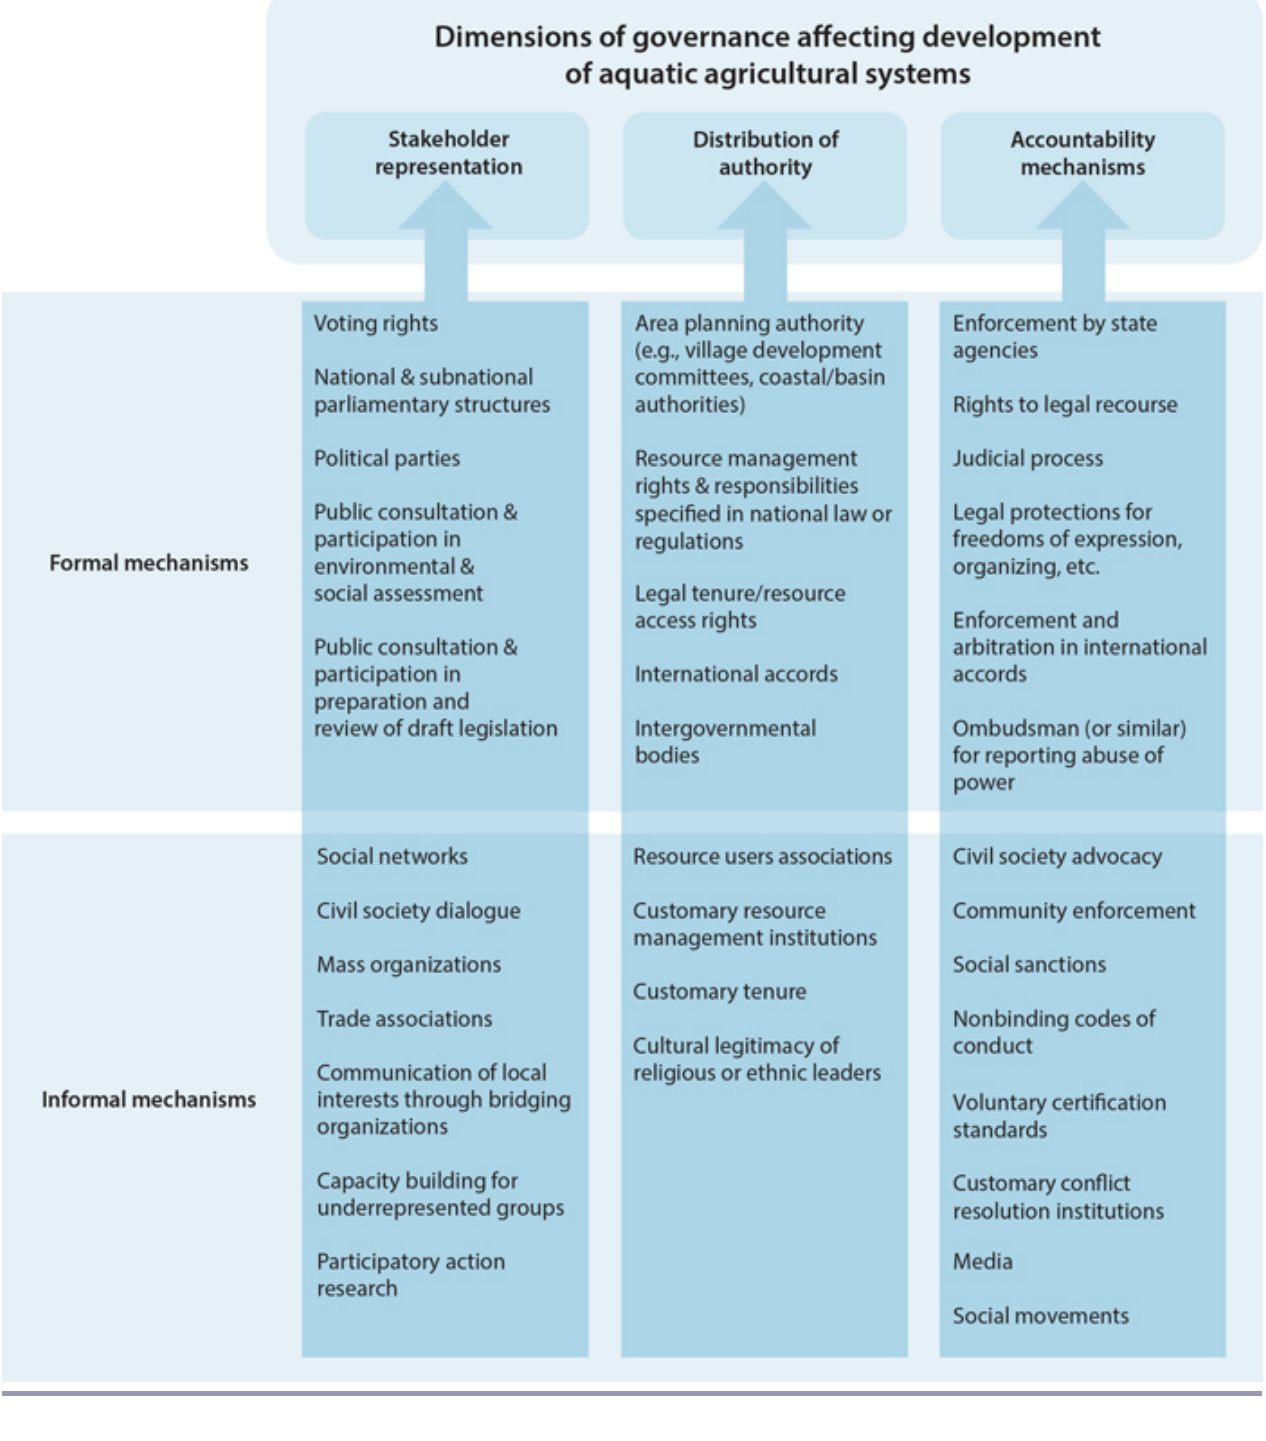
Fig. 2 . Examples of formal and informal mechanisms for three dimensions characterizing the governance context for development of aquatic agricultural systems. Adapted from Ratner and Allison